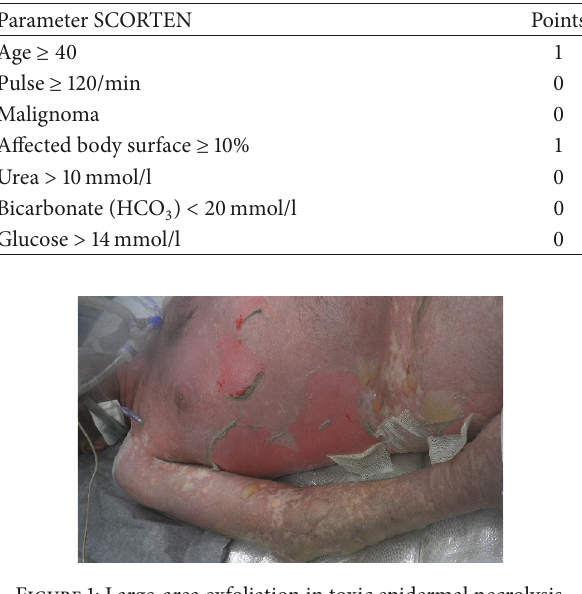
Figure 1: Large-area exfoliation in toxic epidermal necrolysis.